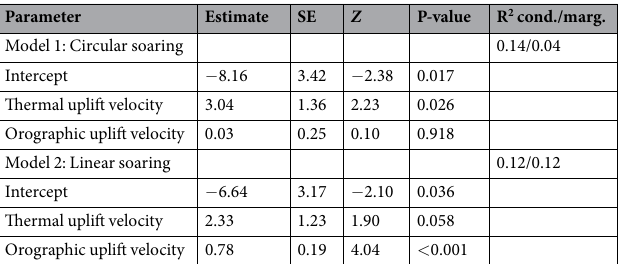
Parameter Estimate SE Z P-value R 2 cond./marg.